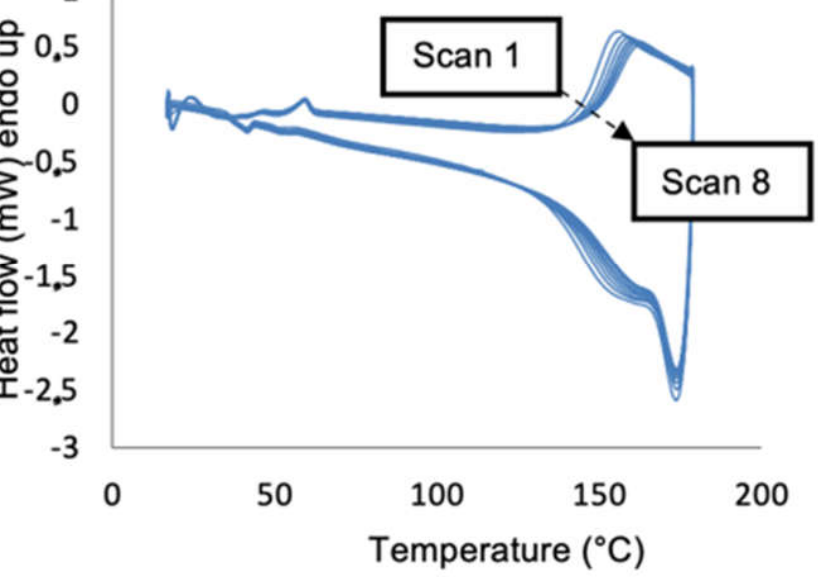
Figure 4. DSC measurements of reversible network formation for